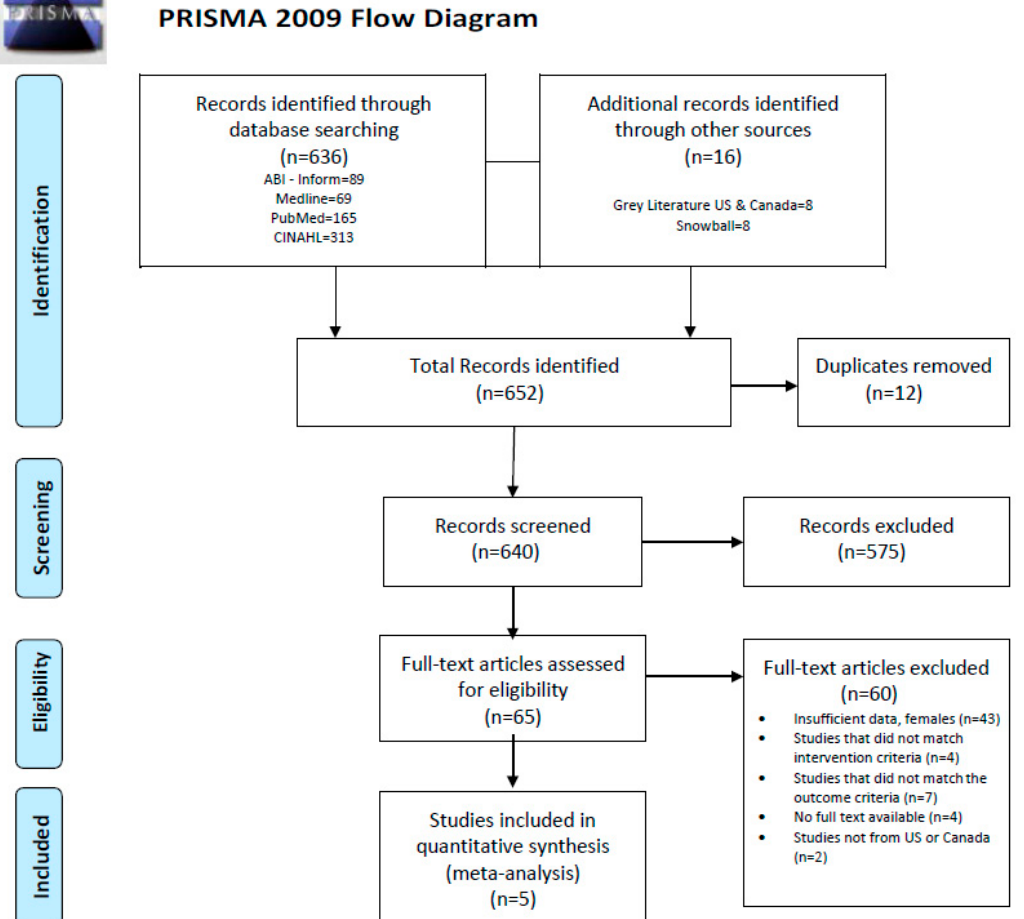
Figure 1. PRISMA diagram, study selection process. Preferred Reporting Items for Systematic Reviews and Meta-Analyses (PRISMA) flow diagram.